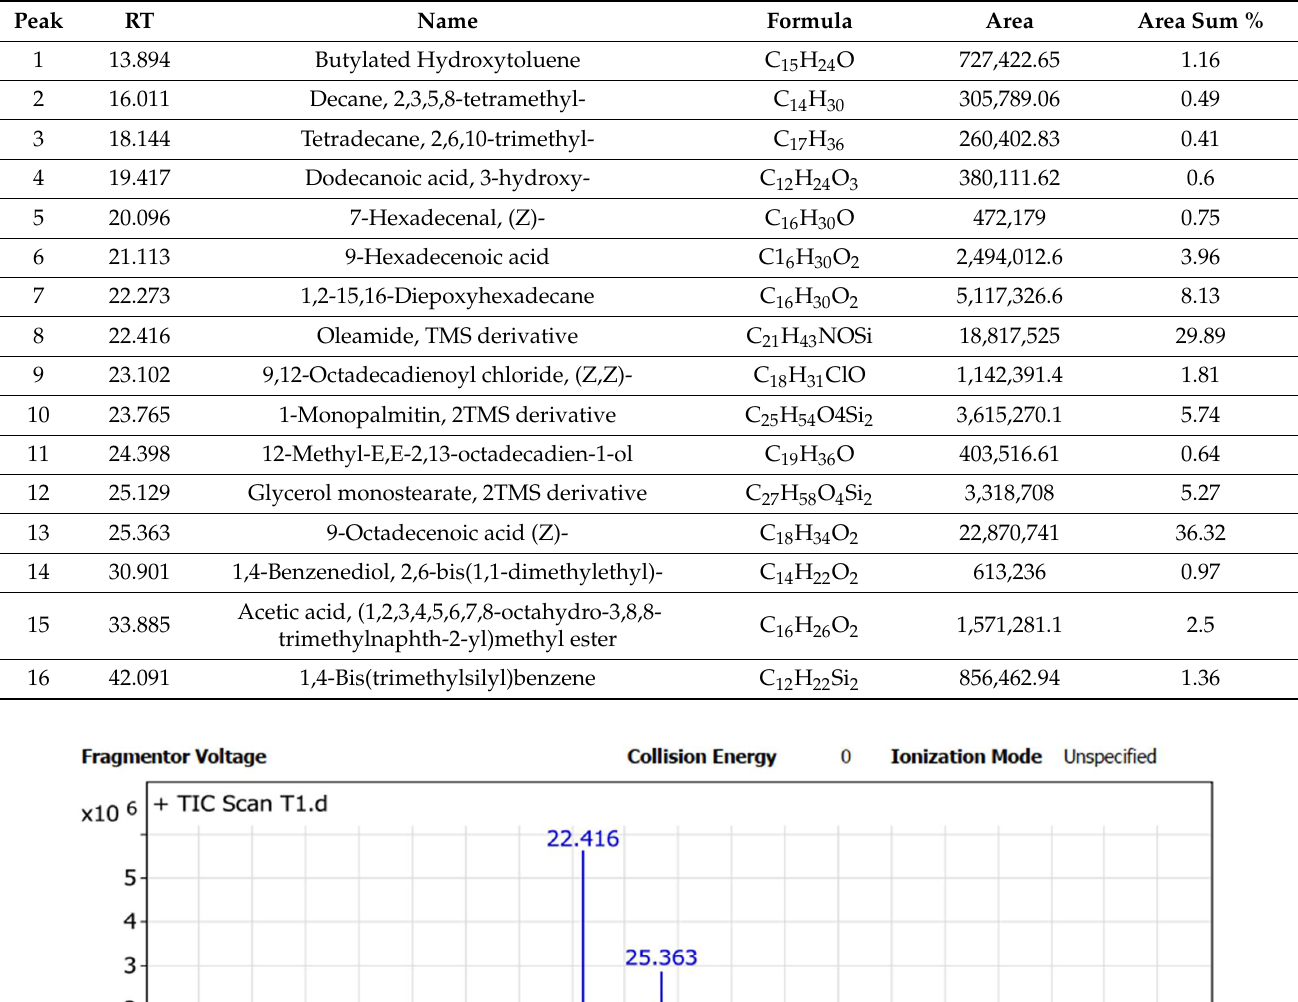
Table 1. Metabolites present in Trichoderma asperellum ZNW filtrate as indicated by GC-MS analysis.